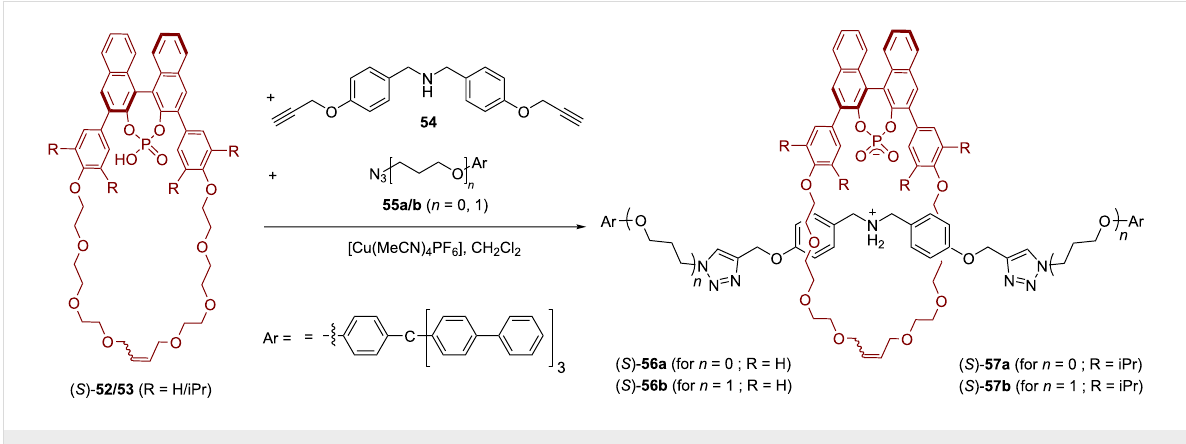
Figure 14: Synthesis of Niemeyer´s chiral [2]rotaxanes ( S )- 56 / 57